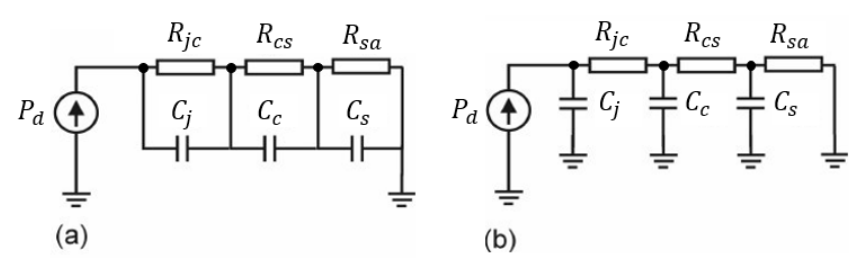
Figure 12. ( a ) Foster’s equivalent thermal circuit; ( b ) Cauer’s equivalent thermal